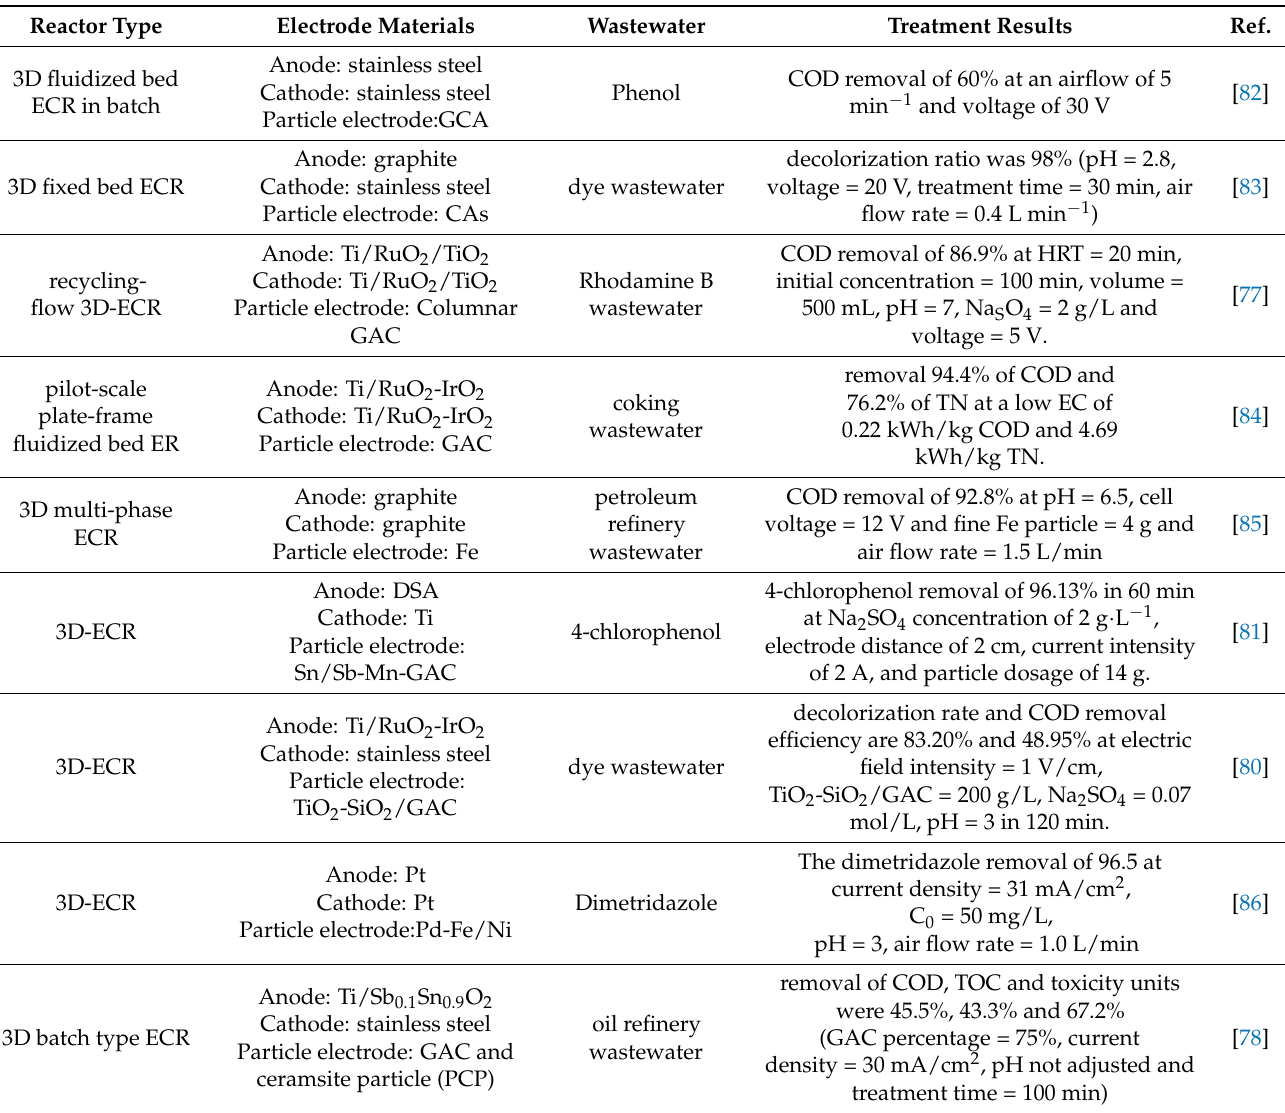
Table 3. Treatment of different organic wastewater by